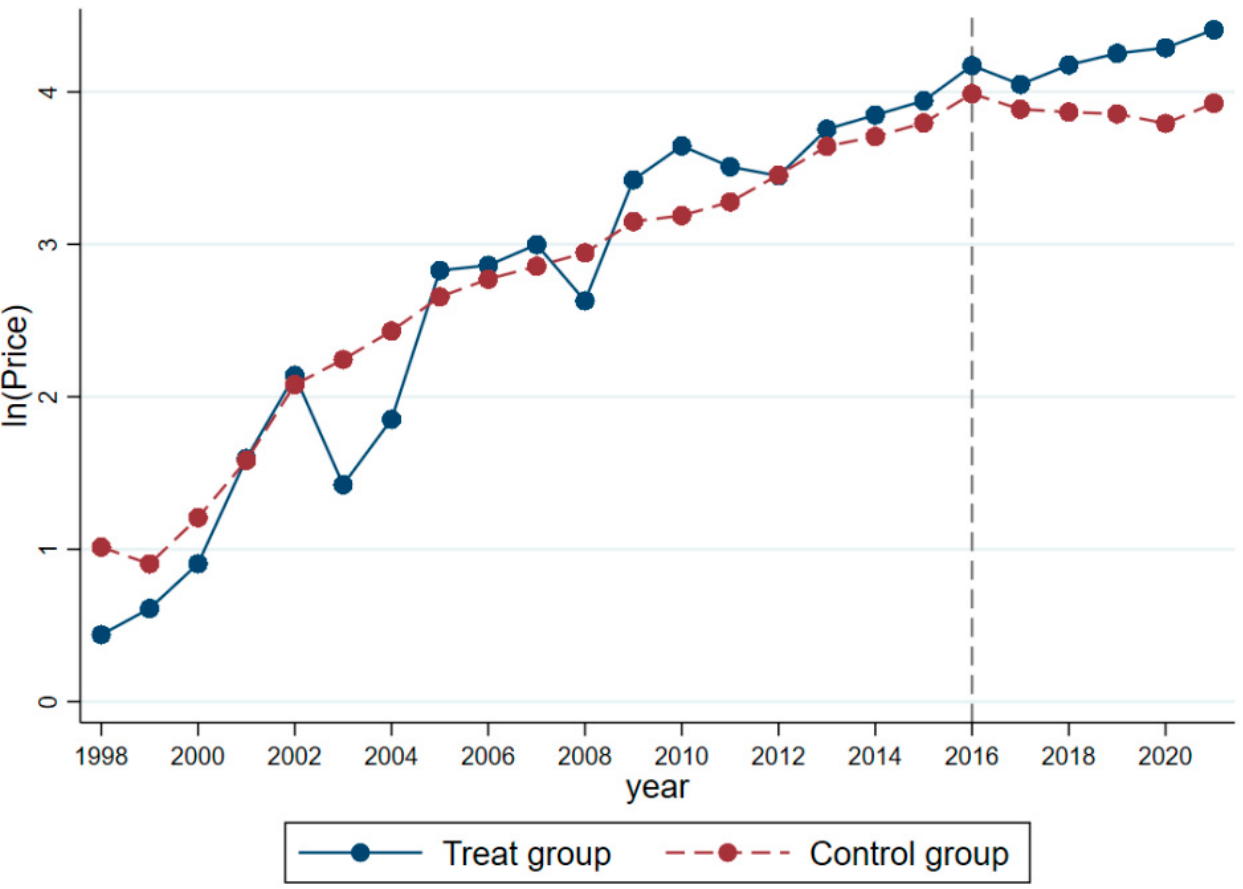
residential transaction Figure 5. Impact of the construction of the National Big Data (Guizhou) Experimental Area on resi- dential transaction price.